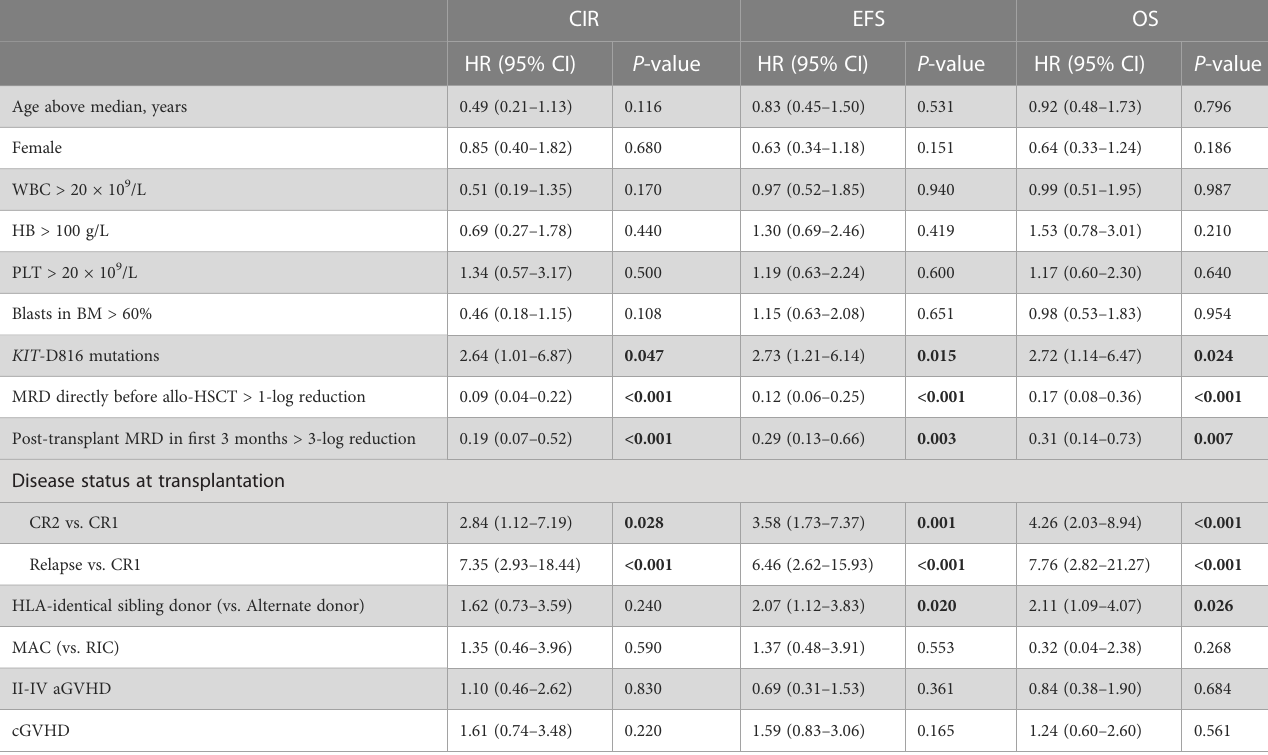
TABLE 2 Univariate analysis of post-transplant CIR, EFS, and OS in t(8;21) AML patients undergoing allo-HSCT. CIR EFS